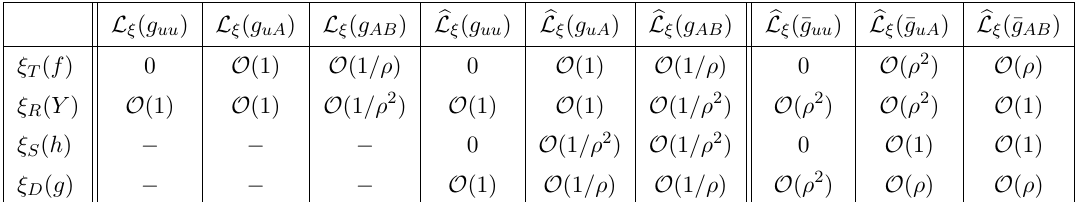
Table 4 . Non vanishing ordinary and conformal Lie derivatives of the metric g µν and ¯ g µν = g µν /w 2 ( x µ ) when considering the vectors in (2.19) for arbitrary functions f ( ~y ) and Y A ( ~y ) , while h ( ~y ) and g ( ~y ) are restricted to